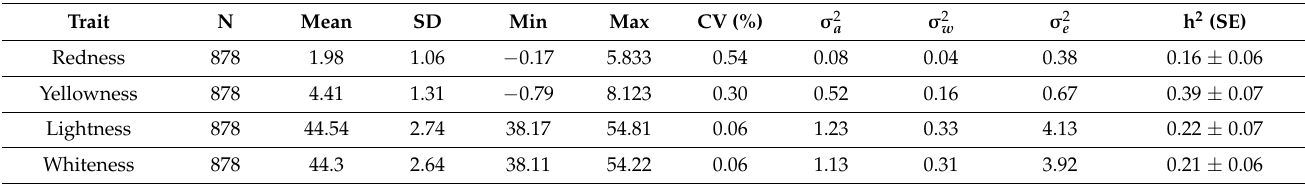
Table 1. Descriptive statistics of the observed